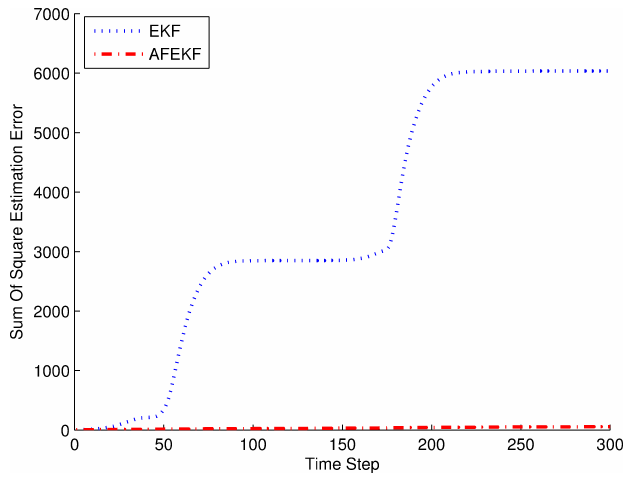
Fig. 5. Sum of the squared estimation errors (Stability conditions are